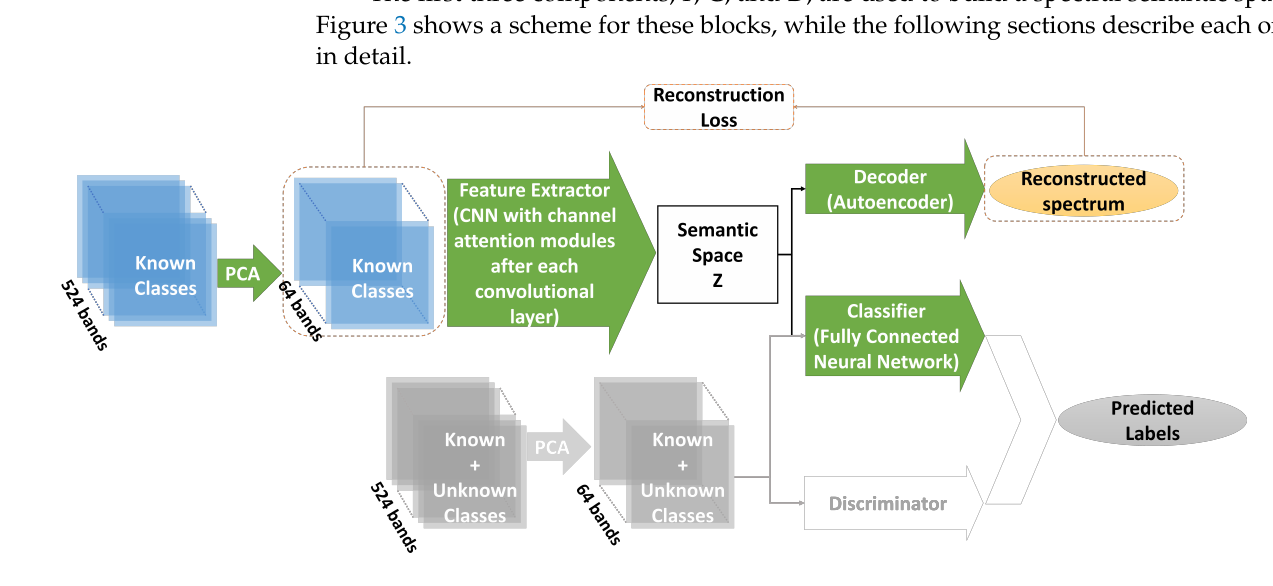
Figure 3. Schematic of the algorithm used: first, the PCA method is used to reduce the data dimen- sionality for both the training and prediction phase. To train the algorithm, first, a feature extractor with channel attention modules after each convolutional layer is used to create a semantic space Z. Then, this semantic space is used for the classifier, a fully connected neural network, and by the decoder to create a reconstructed spectrum. To perform the prediction, both the classifier and the discriminator are used, giving a predicted label to each